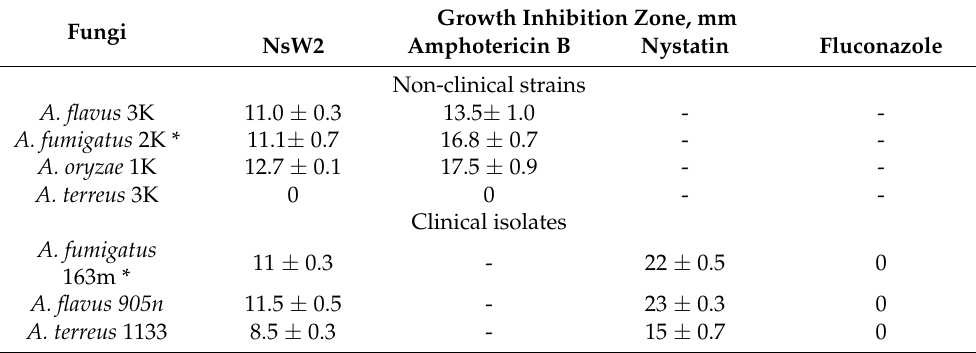
Table 3. Antifungal activity of the NsW2 nigellothionin measured by disc-diffusion assay (mm). * Minimum inhibitory concentration (MIC) = 0.77 µ